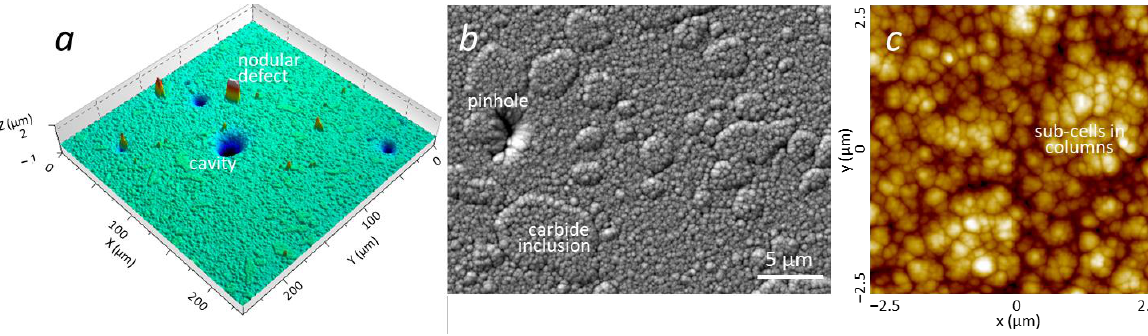
Figure 6. Surface topography appearance of the NL-TiAlN/CrN hard coating sputter deposited on the D2 tool steel substrate using three different surface analytical techniques: ( a ) 3D profile image of a scanning area of 250 µm × 250 µm, ( b ) plain-view SEM image of an area ten times smaller and ( c ) AFM image at a scanning area of 5 µm × 5 µm.